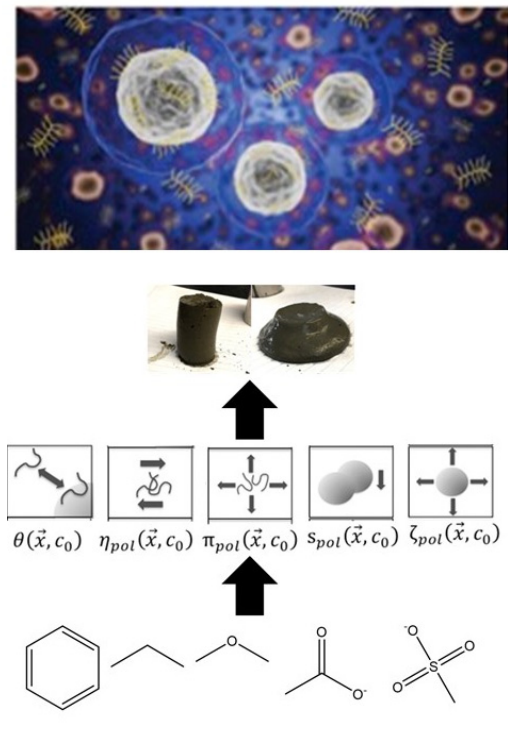
Figure 2. Illustration of interactions of superplasticizers in cement paste depicting both adsorbed and free polymers (top). HML representation of how dispersant chemistry determines the flow, or workability, of cement paste, including effects on both particle and solution characteristics (bottom). Note that in this preliminary study, the cement, mineral, and water variables were all held constant so the final model is only parameterized by polymer chemistry. The HML algorithm requires knowledge of all forces and surrogate physical measurements to provide estimates of their values. This allows it to make accurate predictions based on extremely small training sets but can make it challenging to implement for highly complex